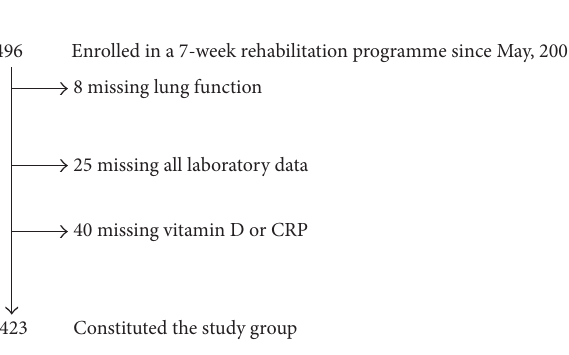
count were positively correlated, and CRP was also positively correlated with BMI and negatively correlated with walking distance and desaturation during exercise. CRP was, however, not correlated with the i-BODE index. Leukocyte count was positively correlated with SGRQ (St. George’s Respiratory Questionnaire) scores (higher scores indicate more limita- tions) and prevalence of heart